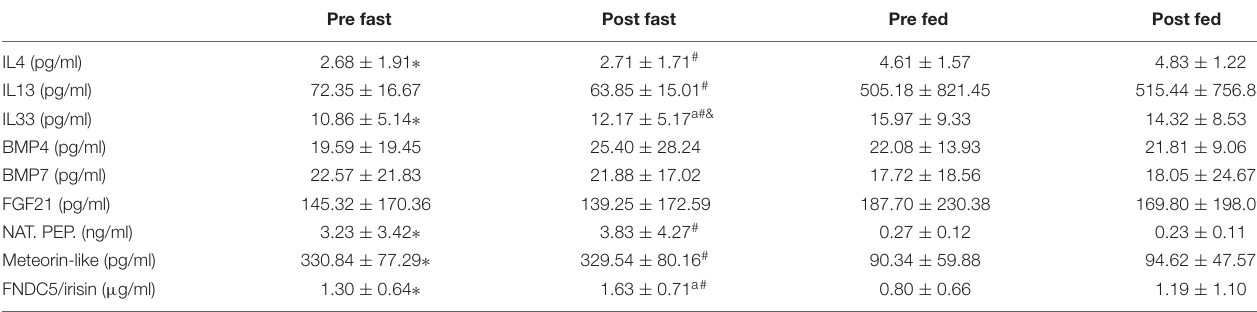
TABLE 3 | Serum thermogenesis inductors in the fasting and fed state before training. Pre fast